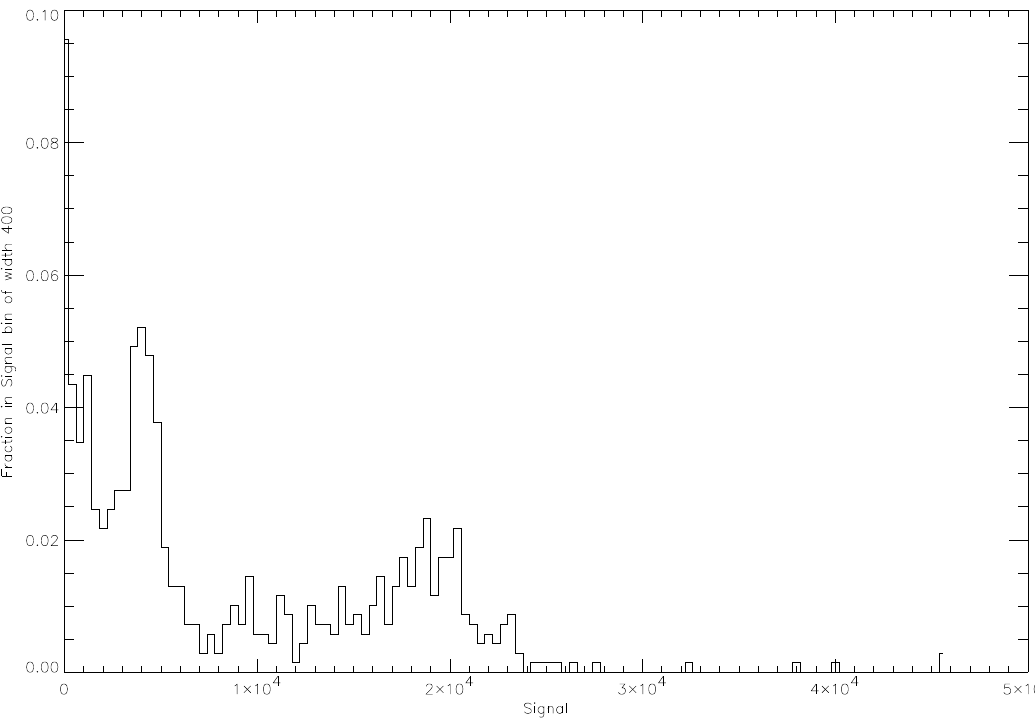
Fig. 6. Histogram of the integrated lidar returns of Fig. 5. This shows 3 peaks, interpreted as the background ( < 800), the clear air returns (800–6000) and cloud returns ( >